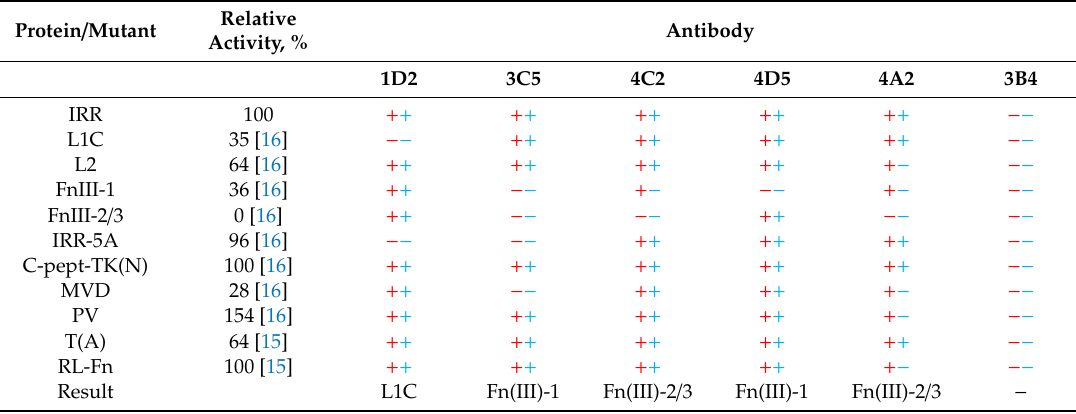
Results of the mapping of the panel of monoclonal antibodies against IRR. The immunoprecipitation data are shown in red, and the immunocytochemistry data are shown in